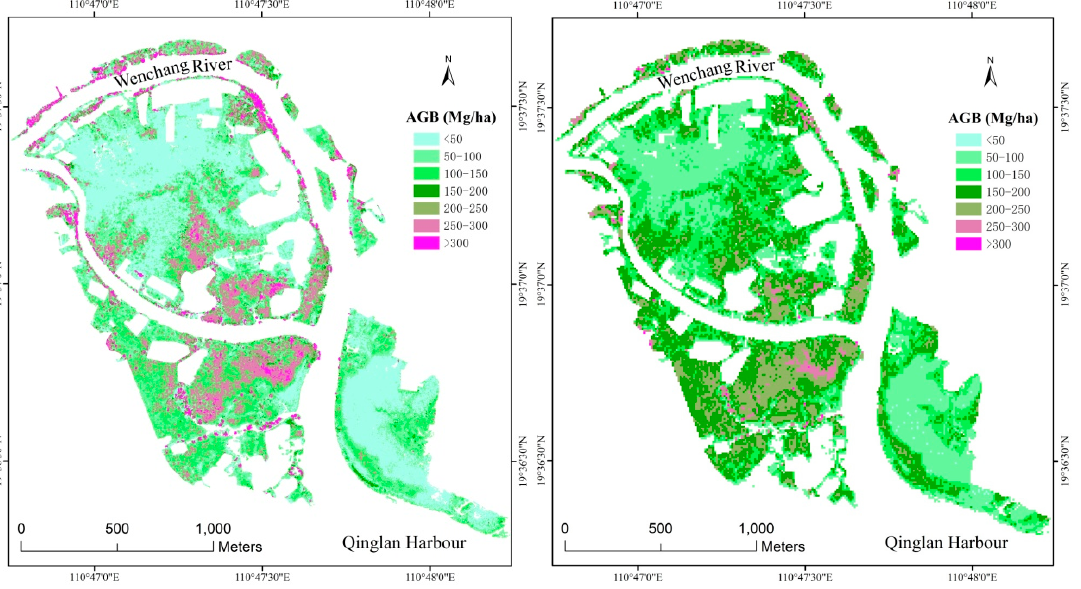
Figure 6. AGB distribution maps of the study area produced from individual tree-based inference method (left) and the grid-based random forest (RF) model method (right).